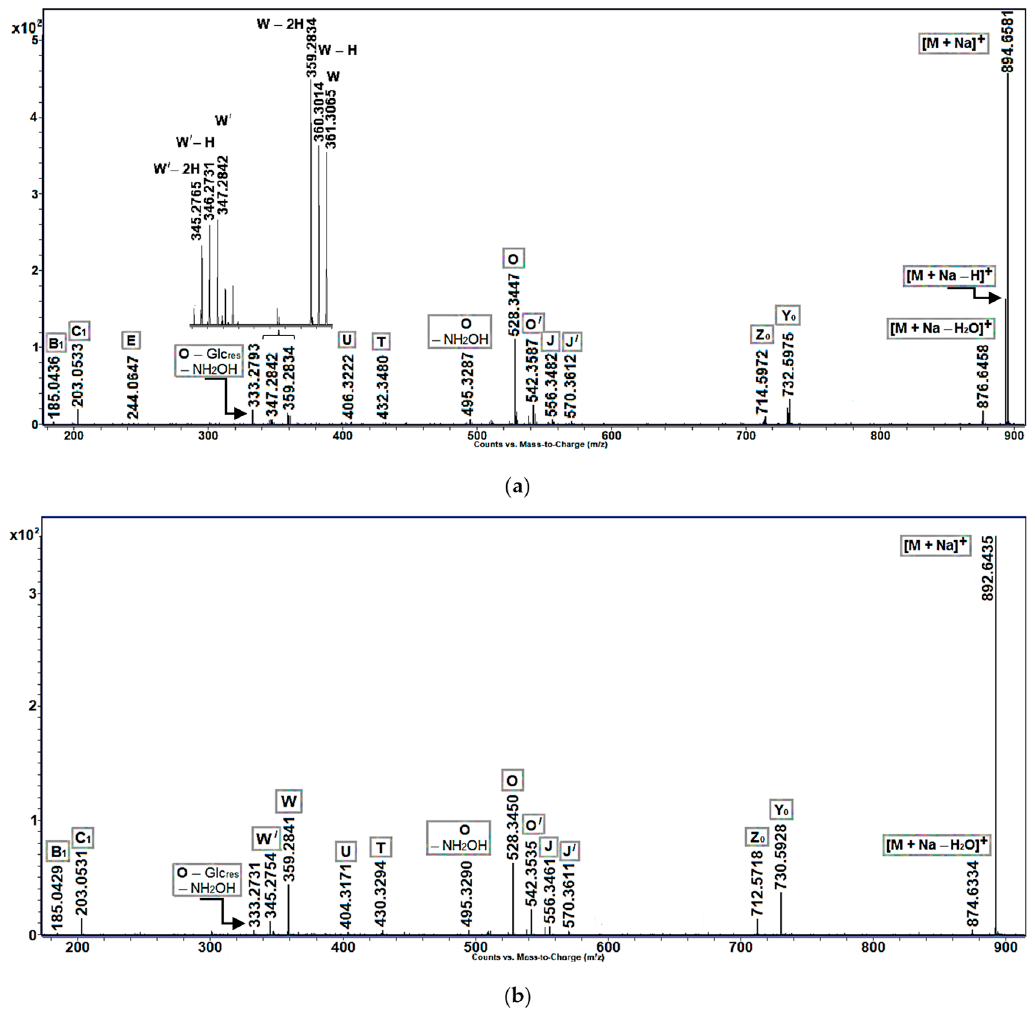
Figure 3. (+)ESI-MS/MS spectra of [M + Na] + ions of isomeric ( a ) allylic alcohols 1 а / , 1b / , 2 а / , 2b / , 3c / , 3d / and ( b ) enones 1 а // , 1b // , 2 а // , 2b // , 3c // , 3d // .